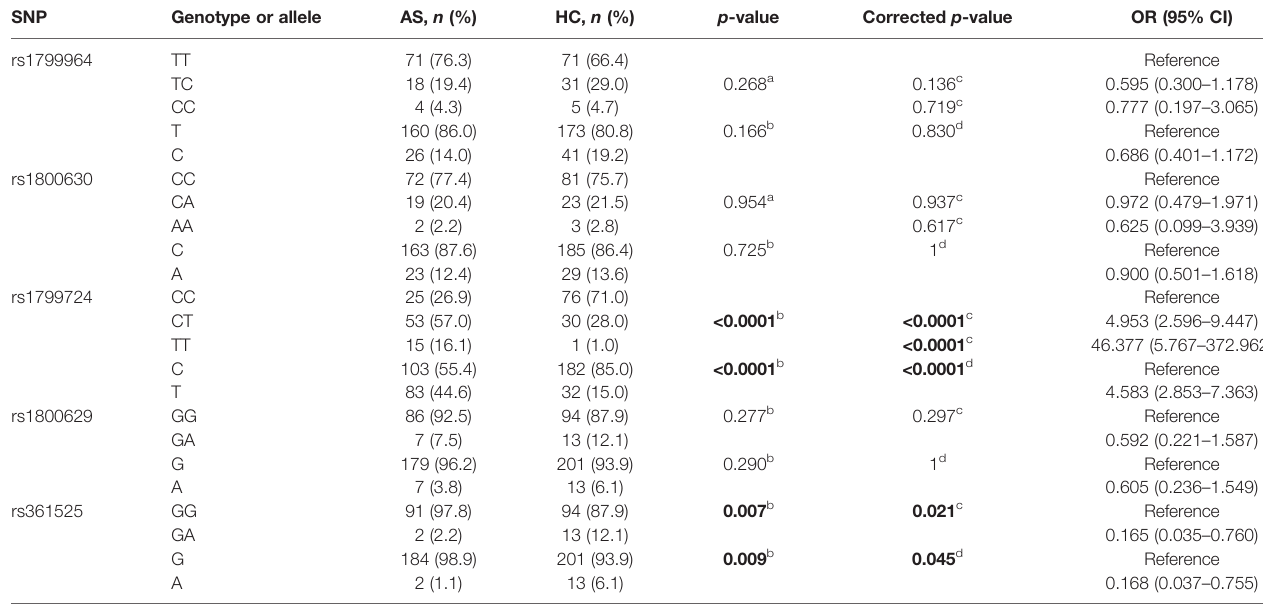
TABLE 2 | Genotypes and allele frequencies of TNF a polymorphisms.